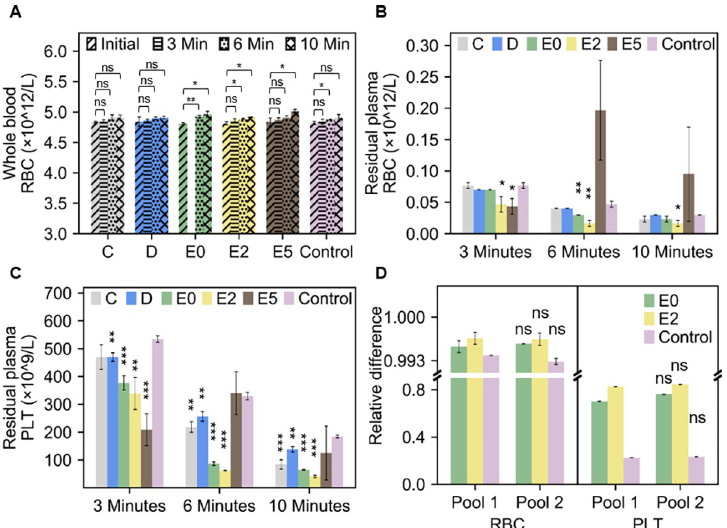
Fig 7. Blood count at 3, 6 and 10 minutes (A) The red blood cell counts of pre (initial) and post (3,6, 10 minutes) separated blood show the integrity of the sample after centrifugation. The statistical indications relate to a non-paired t-test between the RBC counts between 0, 3, 6, and 10 minutes (B) The red blood cell (RBC) count on plasma after centrifugation shows RBC concentration with design E2 was significantly lower than the control in all periods. On the contrary, design E5, although performing well at 3 minutes was hampered by vibrations reversing the separation process. Here the statistics relate to a non-paired t-test between each of the designs and the control, for each time point (C) Platelet count (PLT) on separated plasma. Design E2 was able to separate almost 4 times higher platelet than the control within 10 minutes. Here the statistics relate to a non-paired t-test between each of the designs and the control for each time point (D) Relative RBC and Platelet counts after 10 minutes centrifugation from two different pools of blood. Here the statistics relate to a non-paired t-test between Pool 1 and Pool 2 for each experiment. No significant difference was observed between different pools of